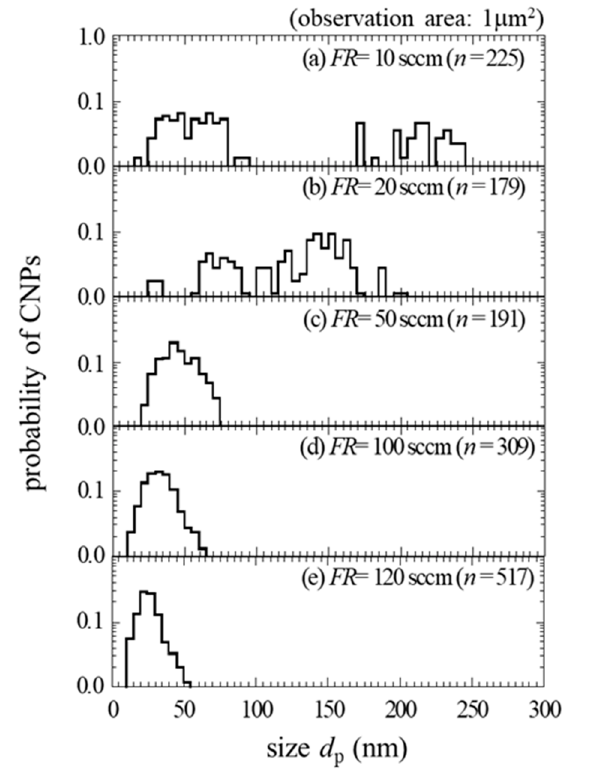
Figure 3. The size distribution of CNPs as a parameter of FR where n is the number of measured CNPs.